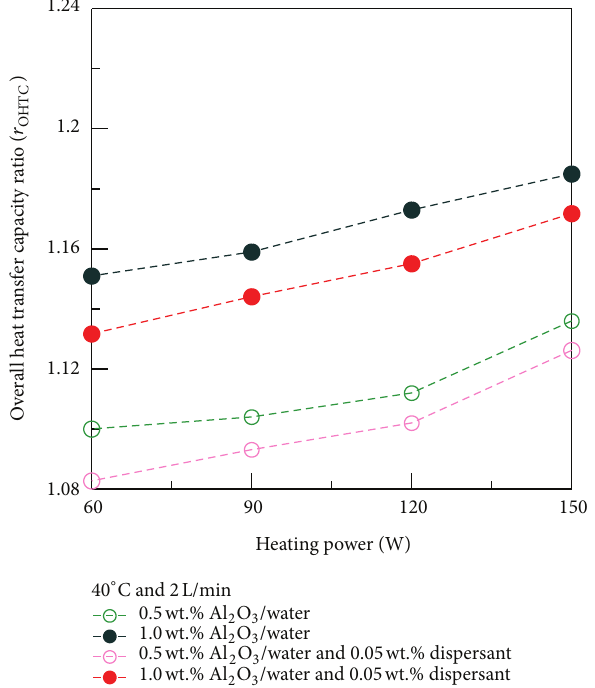
Figure 9: Increment of overall heat transfer capacity (40 ∘ C and